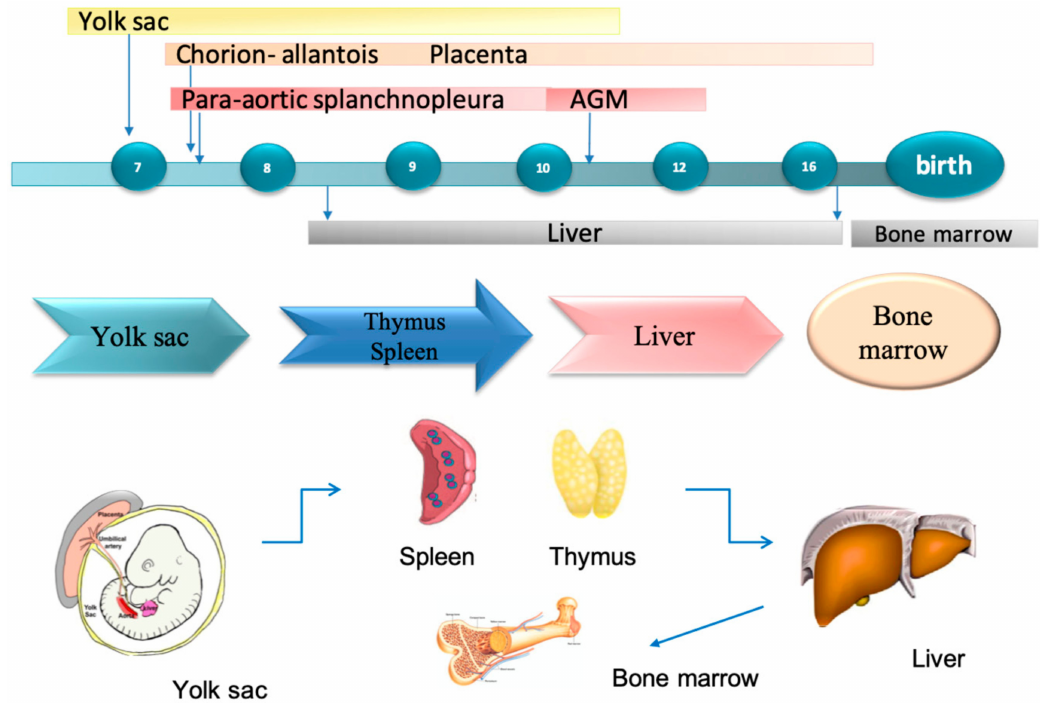
Figure 1. Timeline of fetal hematopoiesis. Primitive hematopoietic cells appear in the yolk sac for seven weeks. Hematopoiesis is then temporarily shared between the liver, spleen, and thymus. After blood circulation starts, primitive hematopoietic cells get into the circulation and mature. At 10 weeks, hematopoietic progenitor cells gradually migrate from the aorta-mesonephros-gonad (AGM) region to colonize the liver, which becomes the major hematopoietic organ. Hematopoiesis shifts from foetal liver to bone marrow at 16 gestational